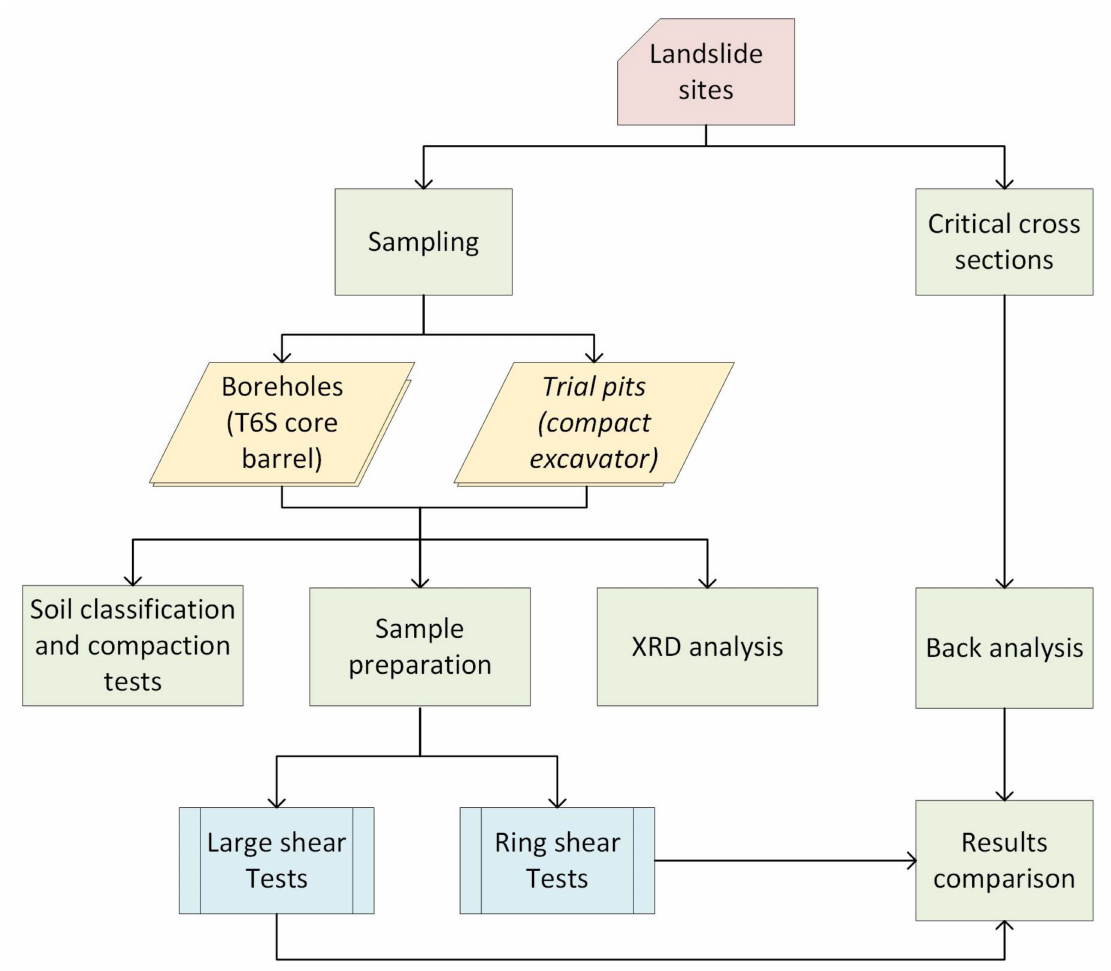
Figure 2. Flow chart of applied methodology. Table 1. Geological characteristics and sampling data of the flysch